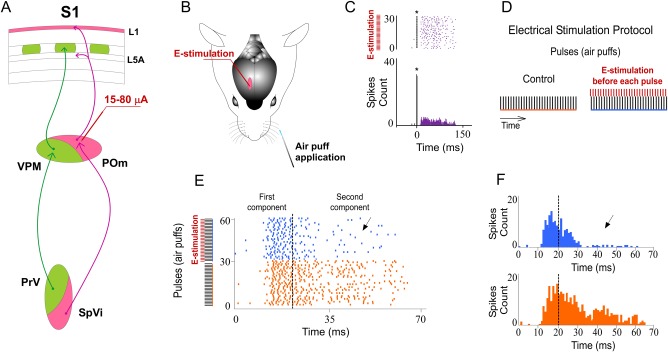
Increasing POm activity by POm E-stimulation just before sensory stimulus modulates whisker cortical responses.(A) Schematic diagram summarizing the main components of the lemniscal (green) and paralemniscal (pink) thalamocortical circuitry to barrel cortex. (B) Schematic diagram indicating the experimental protocol used in our study. (C) In agreement with recent studies suggesting that POm projections make excitatory synapses with barrel cortex pyramidal cells [20, 39, 43, 73], POm E-stimulation alone (single pulse of 0.5 ms; 15–80 μA) elicited orthodromic spikes in infra- and supragranular layers of barrel cortex. An example of evoked orthodromic spikes in the barrel cortex infragranular layer by POm E-stimulation is shown. * indicates stimulation artifacts. (D) Experimental protocol. The ‘Electrical Stimulation Protocol’ consisted of two blocks of 30 pulses (air puff 20 ms) delivered to the principal whisker at 0.5 Hz. We stimulated electrically the POm, VPM, L1 or L5 in S1 50–1000 ms before each pulse in the second block (blue) applied 60 s after the first block (orange). (E, F) POm E-stimulation 500 ms before whisker stimulus reduced sensory responses in infra- and supragranular layers of S1. Raster plots (E) and PSTHs (F) are shown for a sample multiunit infragranular response. Vertical dashed lines separate response components. POm E-stimulation shortened responses and reduced spikes mainly in the second response component (arrows). Spikes are aligned on sensory stimulus (air puff) presentation (Time 0 ms). POm E-stimulation was applied 500 ms before air puffs (31 to 60 pulses; red bars).